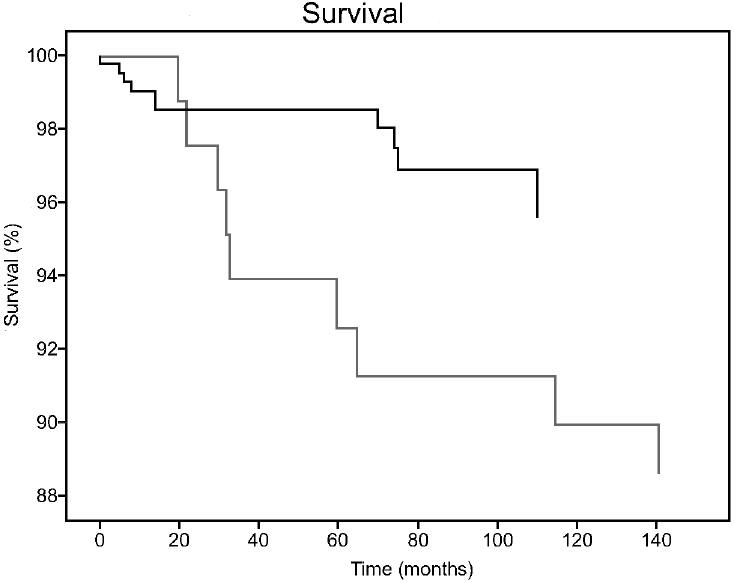
Fig 2. Survival curves of both samples, the known PROGR-S sample (n = 424; black) censored for patients that were out of care at a certain point in time; a graph based on Wiersma et al., 1998 [3] (n = 85; gray) is shown for referential